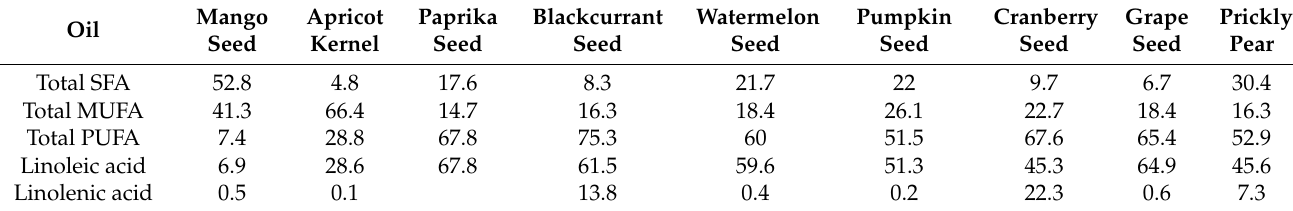
Table 5. Fatty acid profile (g/100 g) of seeds oils